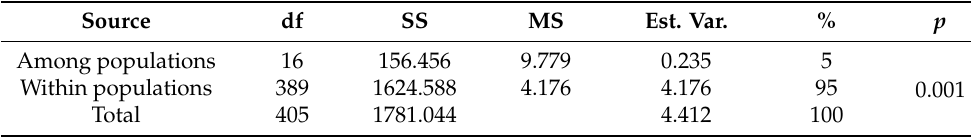
Table 4. Hierarchical Analysis of Molecular Variance